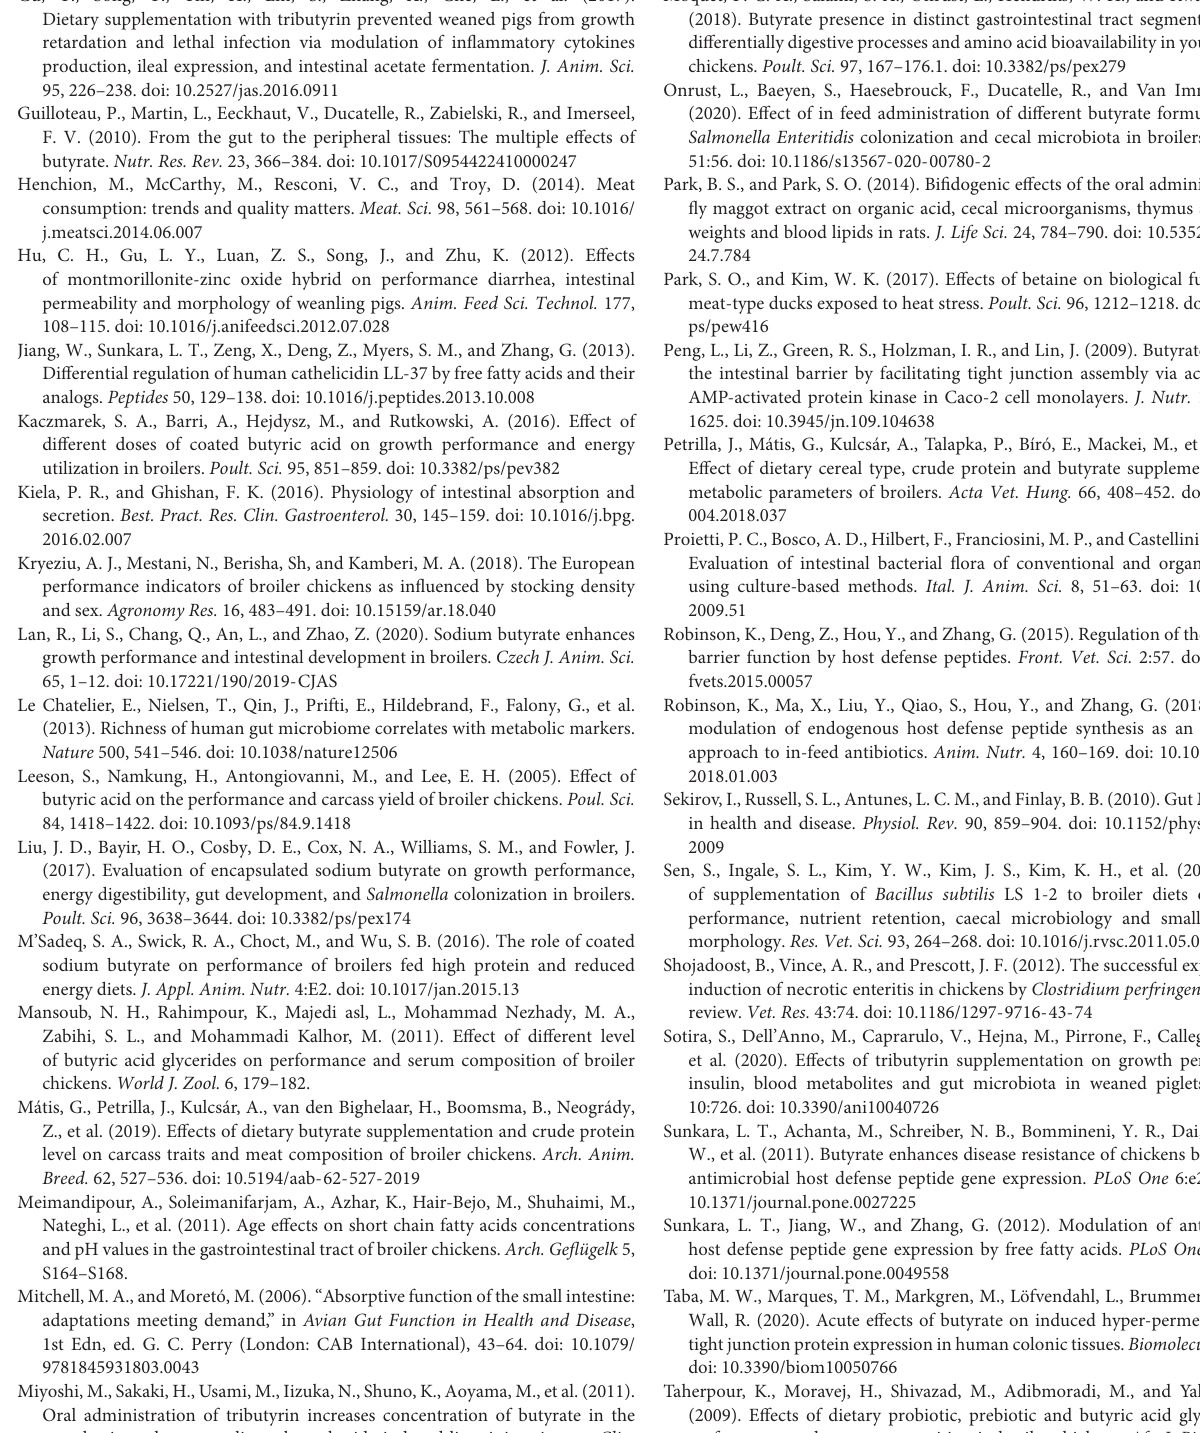
host defense peptide gene expression by free fatty acids. PLoS One 7:e49558. doi: 10.1371/journal.pone.0049558 Taba, M. W., Marques, T. M., Markgren, M., Löfvendahl, L., Brummer, R. J., and Wall, R. (2020). Acute effects of butyrate on induced hyper-permeability and tightjunctionproteinexpressioninhumancolonictissues. Biomolecules 10:766. doi: